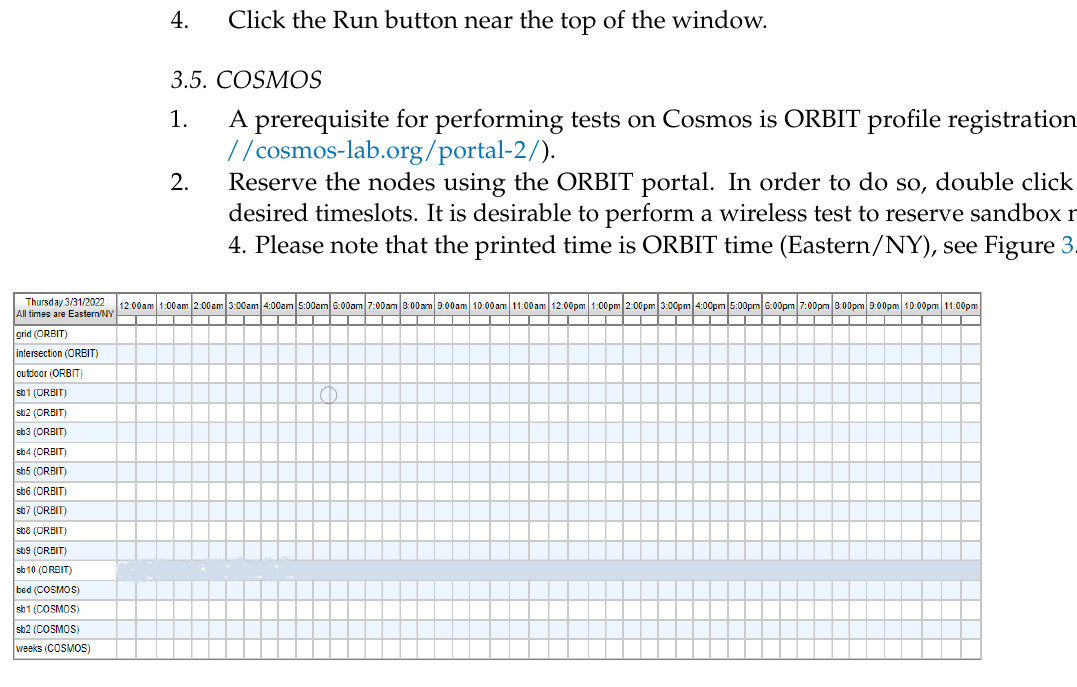
Figure 3. COSMOS GUI test reservation procedure.